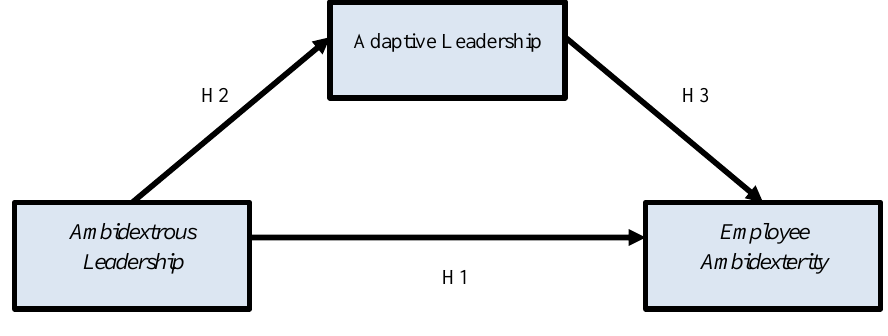
Figure 1: Conceptual Model of the Study; Source: